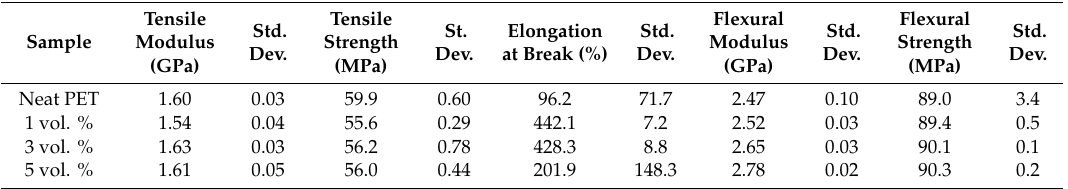
Table 9. Tensile Properties of Al 2 / amorphous PET composites. Std. Dev. is the standard